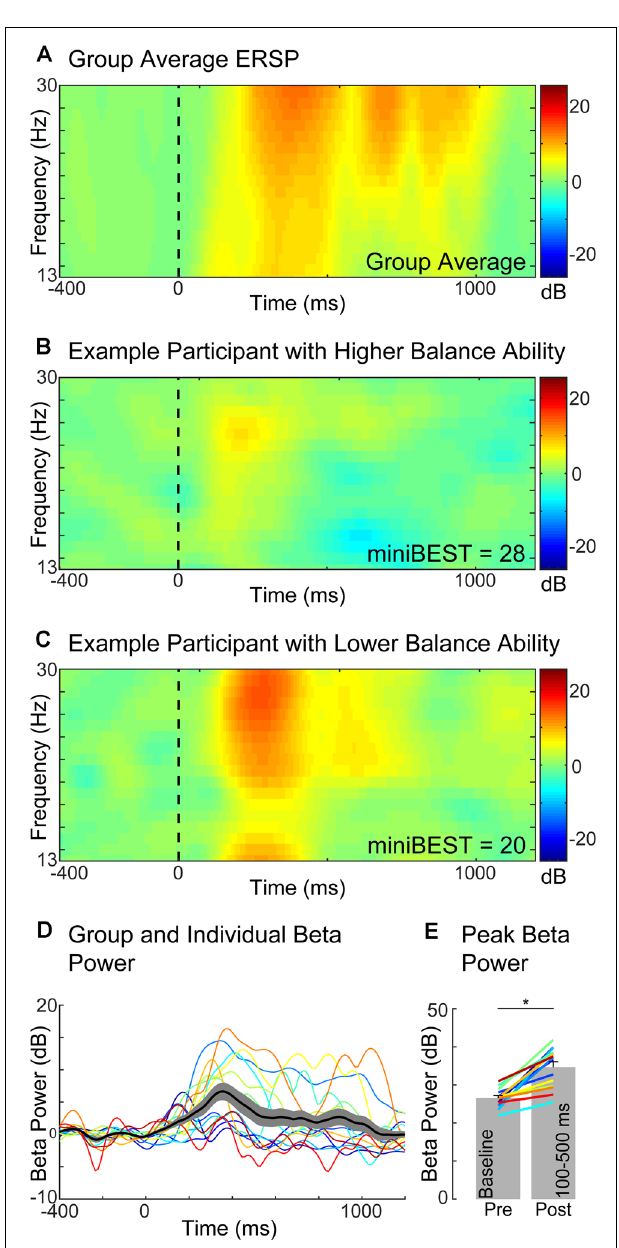
FIGURE 3 | Motor cortical beta oscillatory power (Cz) during reactive balance responses. Group level event-related spectral perturbation (ERSP) in the beta frequency range (13–30 Hz). (A) ERSP in two exemplary individuals with higher (B) and lower (C) miniBEST score. Time course of beta power response across individuals. (D) Beta power increased from pre-(27 ± 2 dB) to post-perturbation (100–500 ms; 35 ± 5 dB; * p < 0.0001) (E)